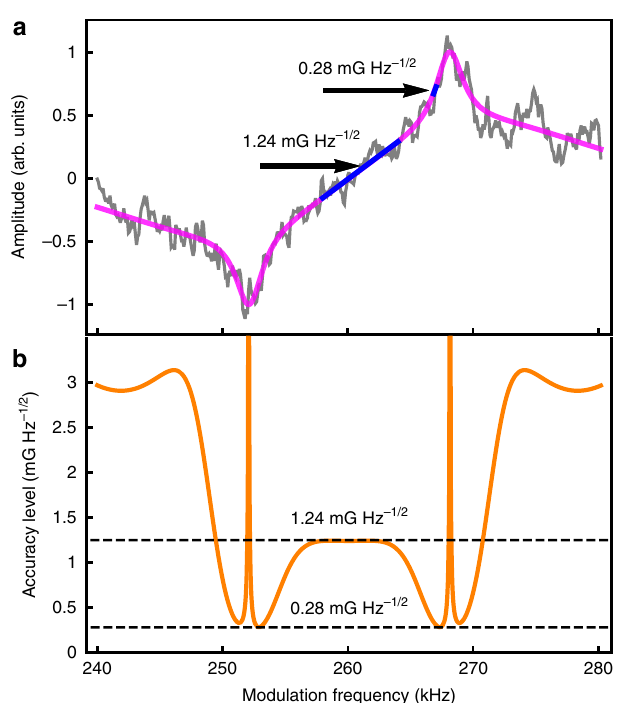
Fig. 5 Estimate of magnetometry accuracy. a A resonance acquired with the lock-in ampli fi er in good atmospheric conditions (seeing 0.7 arcsec) with δ f = 8 kHz. b Magnetometry accuracy level from the derivative of the resonance fi t function. The maximum sensitivity of 0.28 mG Hz − 1/2 is achieved at the steepest points of the